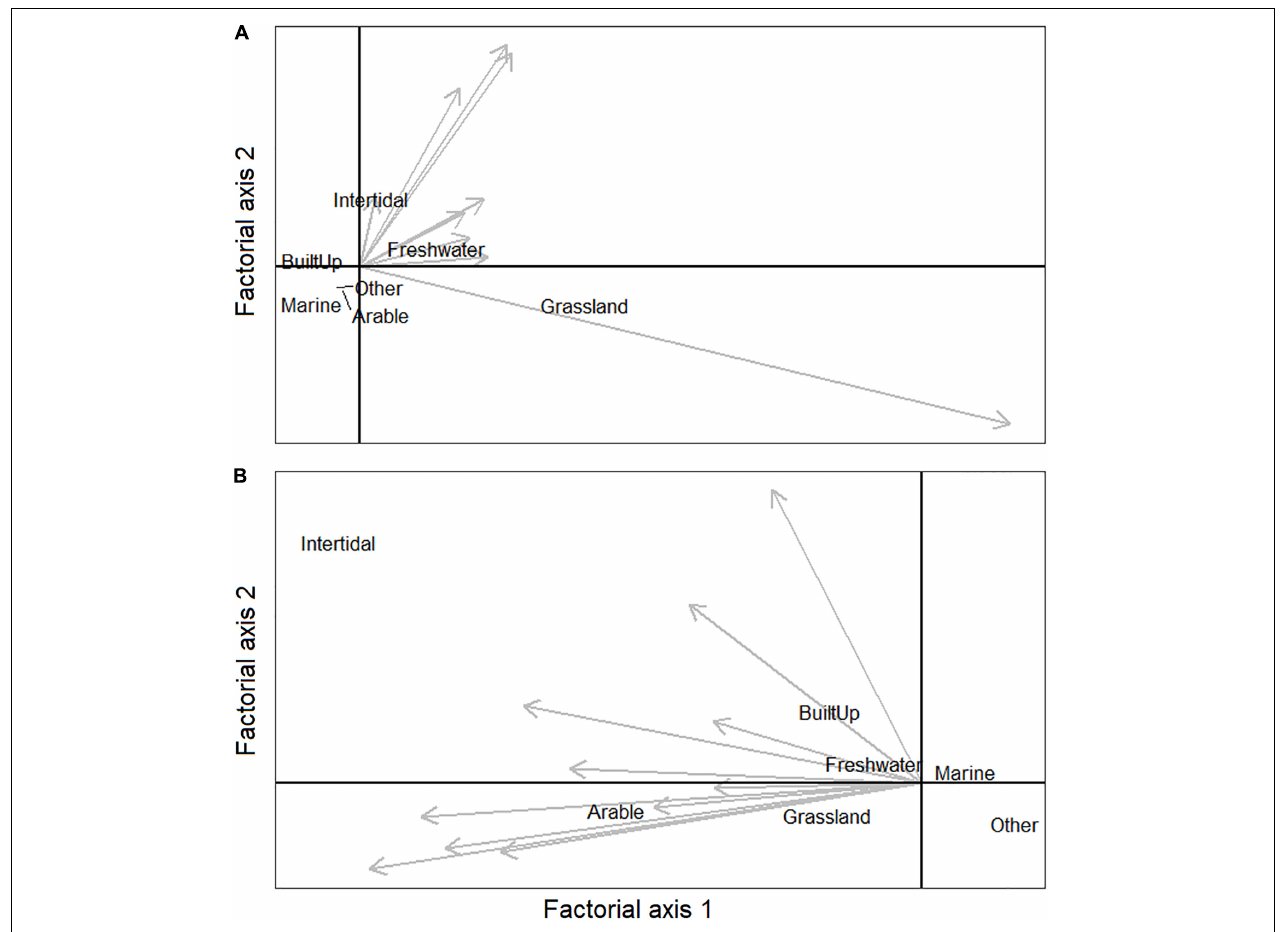
FIGURE 3 | Plot of Eigenanalysis of selection ratios for herring gulls using the non-breeding regions (A) northwest England and (B) southwest Scotland. The position of habitats reflects the biological significance of the first two factorial axes. The position of the arrows indicates the habitats selected by different individual gulls, with no selection in the centre of the axes. Eigenanalyses maximise the differences between habitat use and availability on the first factorial (horizontal) axes. If all individuals select the same habitat types, then all variation in selection is explained on the first factorial axis whereas the among-individual variation in habitat selection is distributed across the second factorial (vertical) axis. The first factorial axis explained 76.7% of the selection ratio variance for northwest England and 49.2% for southwest Scotland. The second factorial axis explained 23.3% of the selection ratio variance for northwest England and 50.8% for southwest